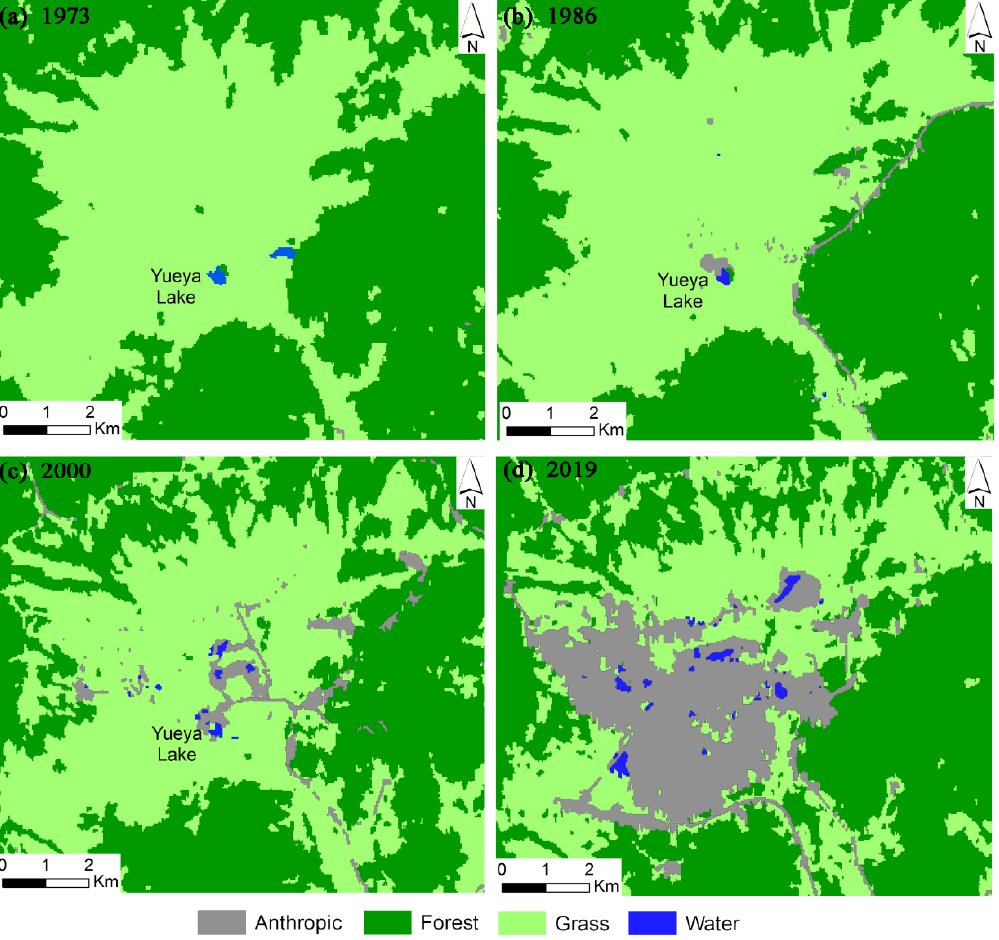
Figure 6. LUCC around the Yueya Lake and the Gulian’he coal mine for the years: ( a ) 1973, ( b ) 1986, ( c ) 2000, and ( d ) 2019.